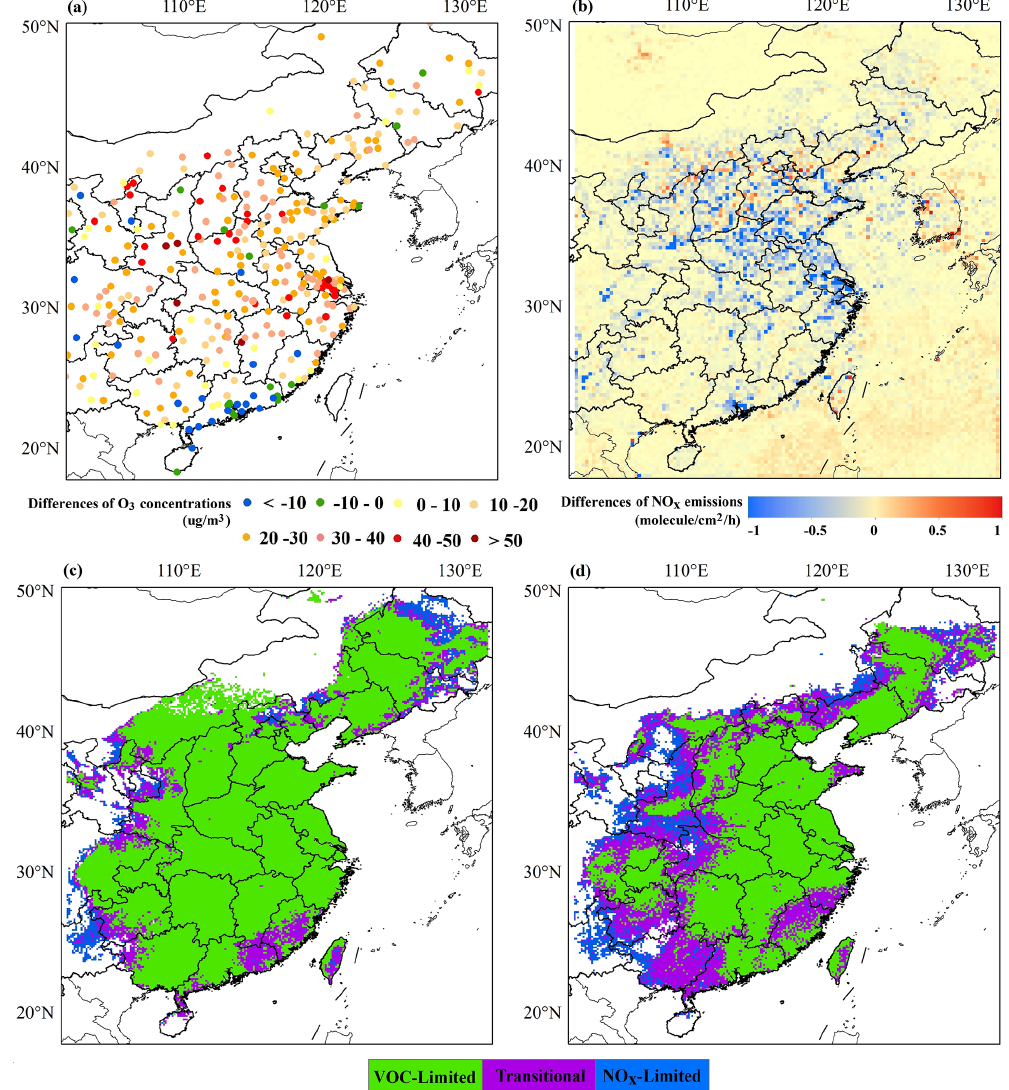
Figure 6. (a) Differences in mean ground-based O 3 concentrations in east China between period I and period II. (b) Differences in mean NO x emissions in east China between period I and period II. (c) O 3 formation sensitivity in east China during period I. (d) Same as (c) , but for period II. Note that period I (3–23 January 2020) is before the lockdown, and period II (9–29 February 2020) is during the